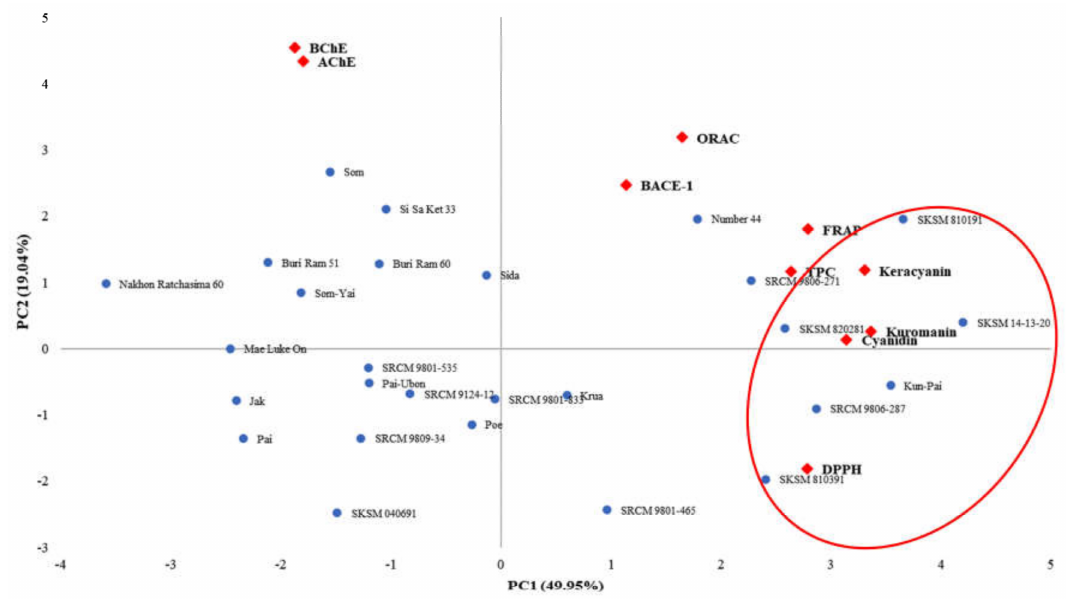
Figure 2. Biplot of principal component analysis from mean value of all variables ( • ) investigated in twenty-seven Morus cultivars ( (cid:7)